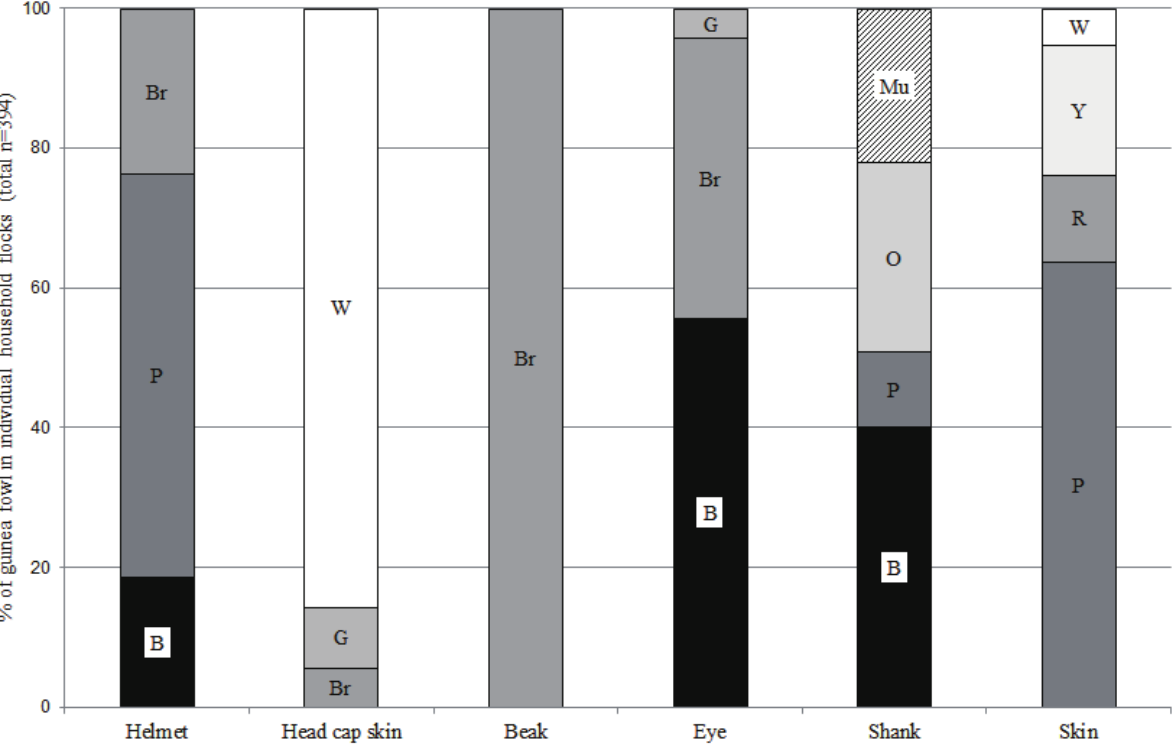
Figure 2. Color distributions of local guinea fowl in individual household flocks. Total number of birds n = 394; total number of household flocks n = 35. B: black, Br: brown, G: grey, W: white, R: red, O: orange, Y: yellow, P: purple, Mu: multiple colors. X 2 statistics: 252.7 for helmet color, 483.1 for head cap skin color, 141.8 for eye color, 142.7 for shank color, 293.9 for skin color; all p<0.001.